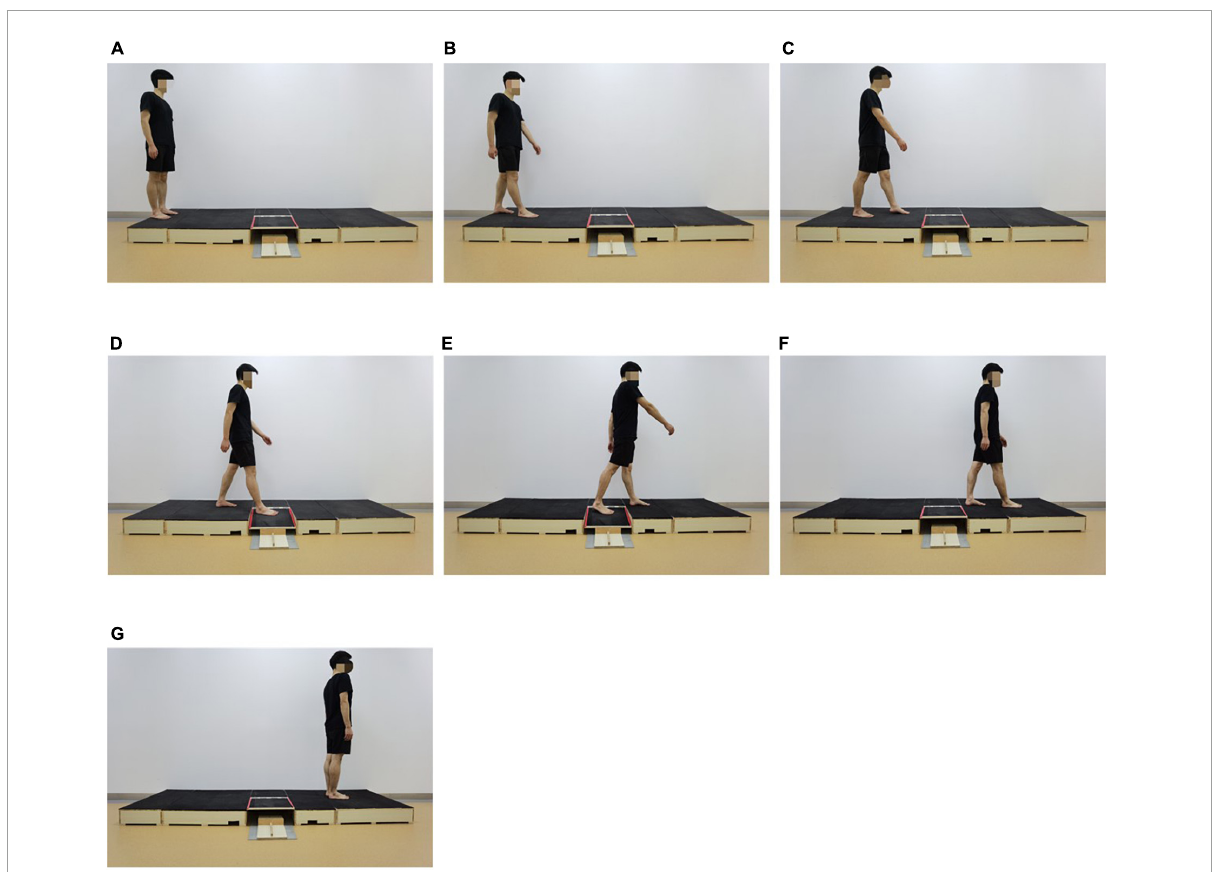
FIGURE3 The AIDAW test. (A) : Starting position; (B) : Step 1; (C) : Step 2; (D) : Step 3; (E) : Step 4; (F) : Step 5; and (G) : Step